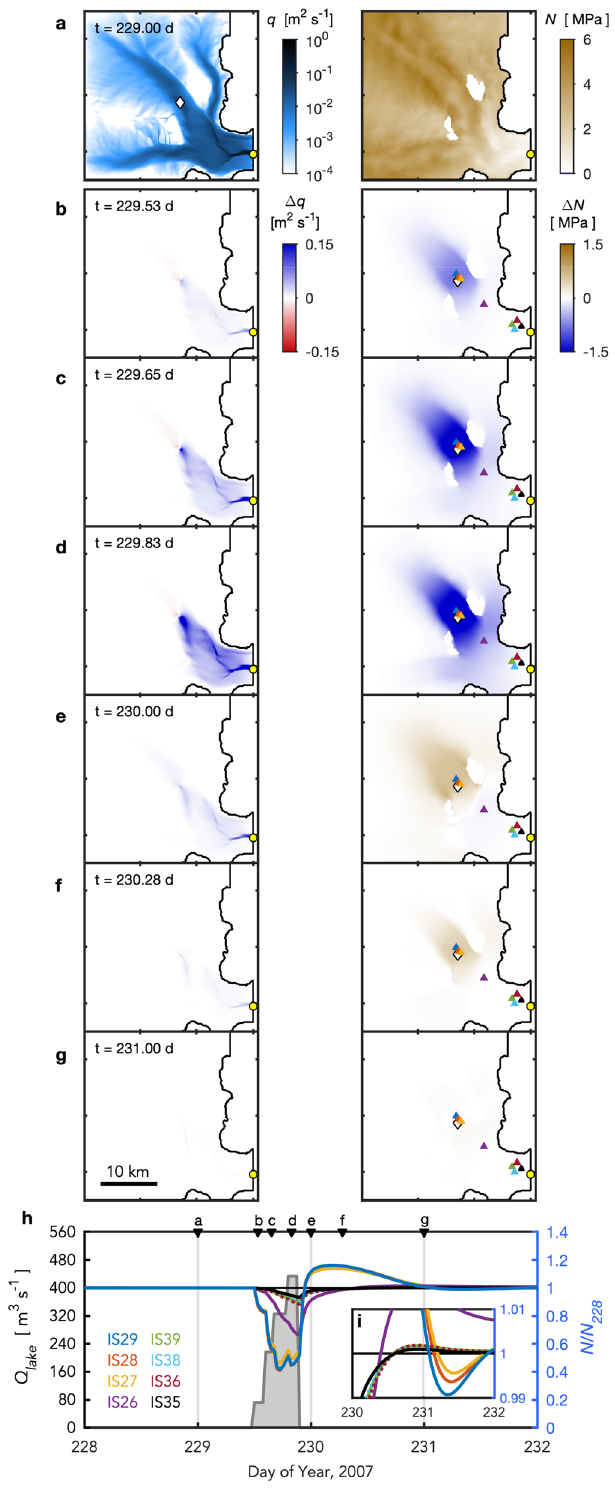
Fig. 3|Modeledeffective-pressureresponsetosimulatedlakedrainage.a (left) Discharge q and (right)effective pressure N priorto simulated rapid lake drainage. The yellow circle shows the discharge outlet location along the glacier terminus. White diamond shows the location of simulated lake drainage. b – g Difference between modeled values of q and N at six time points during the simulated lake drainage and the model values shown in a at 2007/229.00 and prior to the start of thesimulatedlakedrainage.TrianglesshowGPSstationlocations. h (grayshading) Prescribed lake discharge Q lake and (curves) modeled effective pressure at the location of each GPS station, plotted as N = N 228 , where N 228 are individual average values of N at each GPS station location on 2007/228. Black triangles mark time slices shown in ( a – g ). i Modeled effective pressure from 2007/230 – 232 at the location of each GPS station, plotted as N = N 228 , over a fi ner range in N = N 228 than shownin( h ).GPSstationcolorsasinFigs.1and2.Modelsimulationusesparameter values K s =1Pa − 1 s − 1 and σ =10 − 6 . Source data are provided as a source data fi